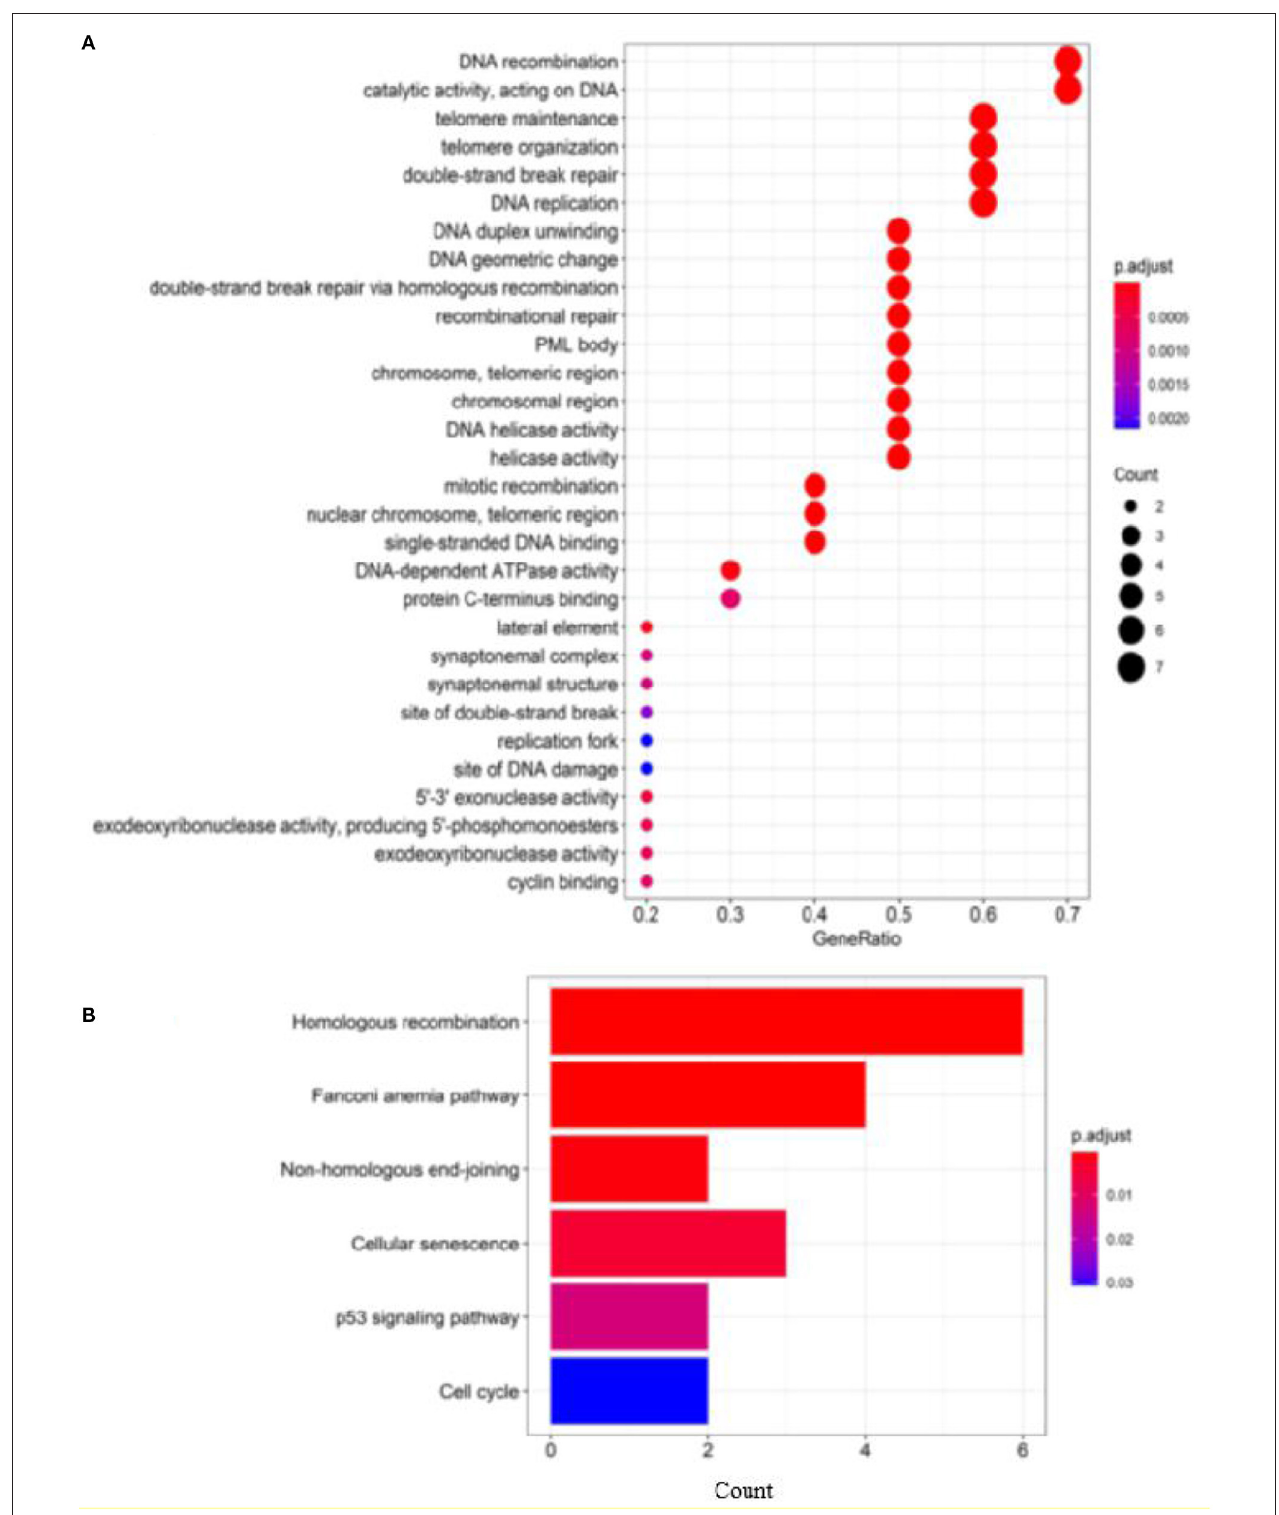
FIGURE 7 | Enrichment analysis of top 10 candidate genes for breast cancer: (A) GO enrichment analysis and (B) pathway enrichment analysis.